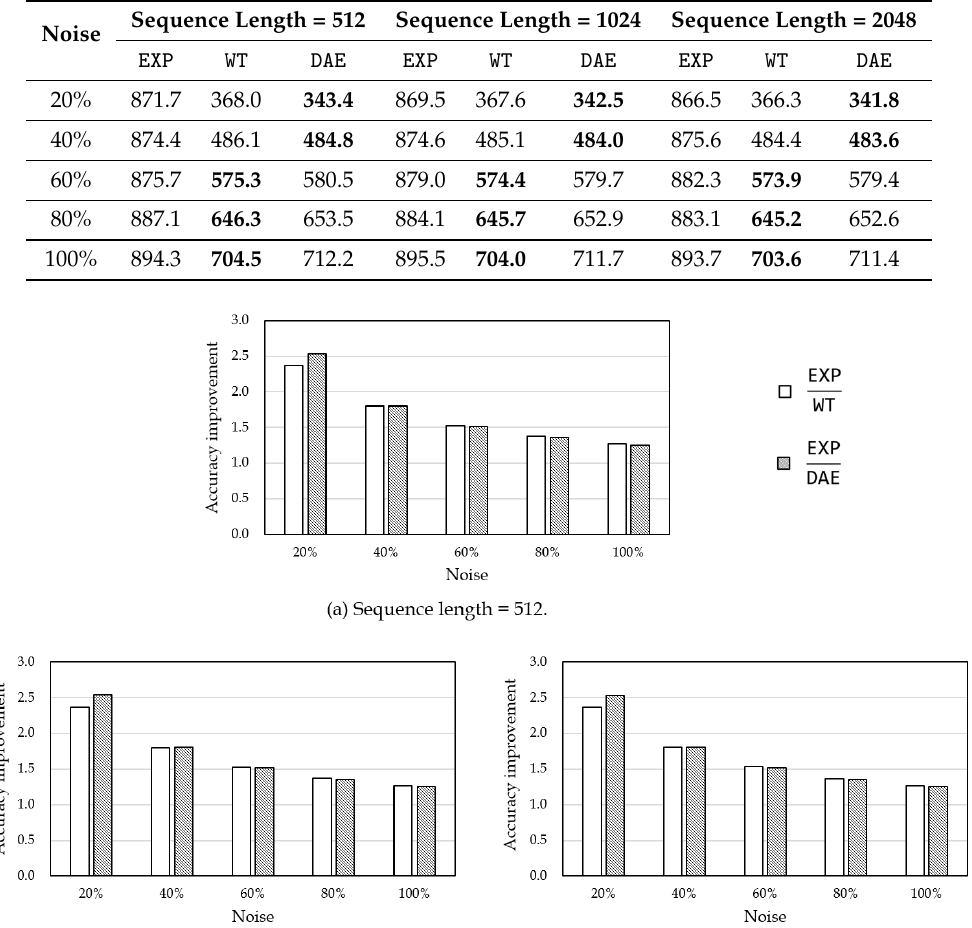
Table 2. Filtering accuracy on power data of different sequence lengths. The boldface numbers denote the best value in each experiment.